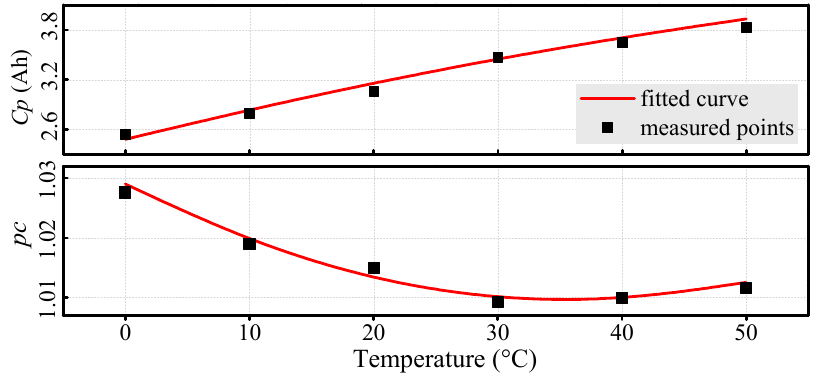
Figure 3. Fitting the (cid:1829) (cid:3043) and (cid:1868)(cid:1855) with polynomials.